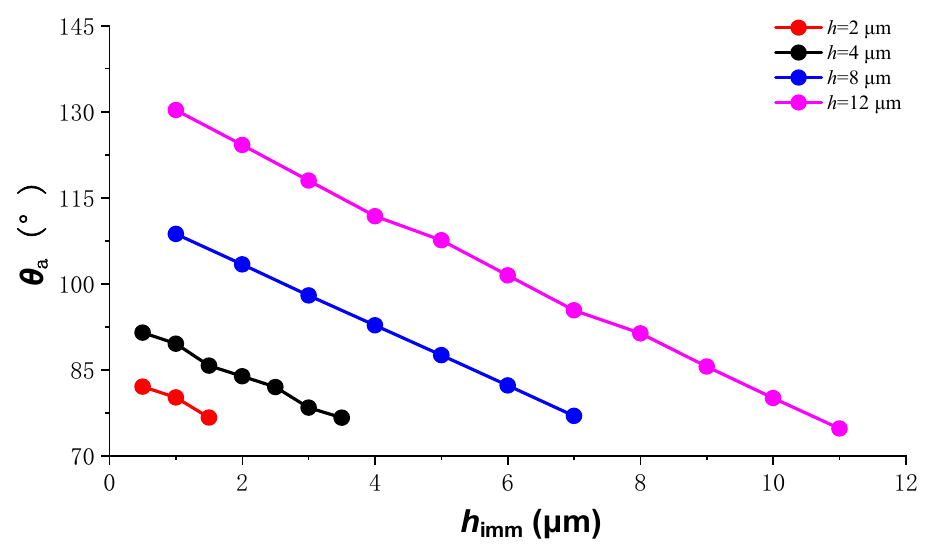
Figure 7. Variation range of apparent contact angle at different microstructure depths.